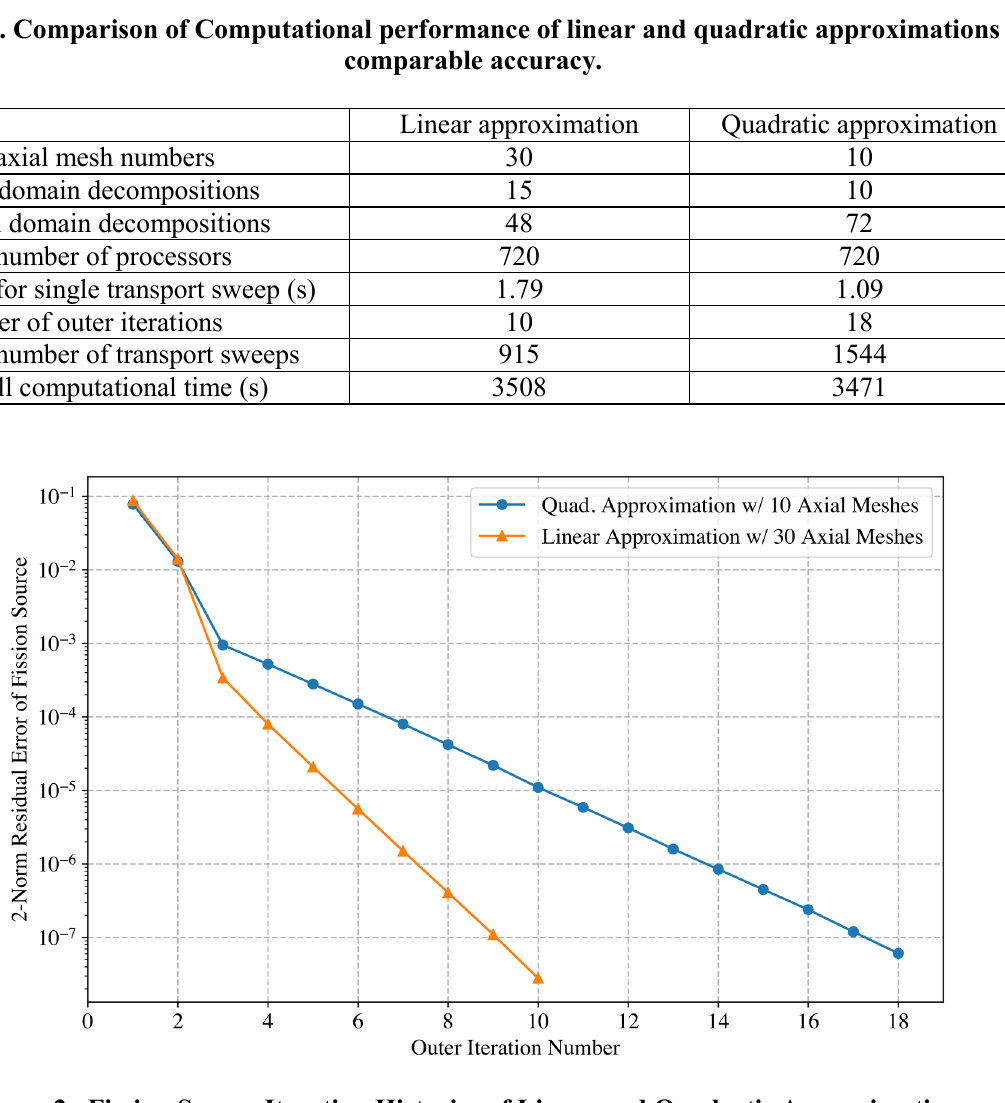
Figure 2. Fission Source Iteration Histories of Linear and Quadratic